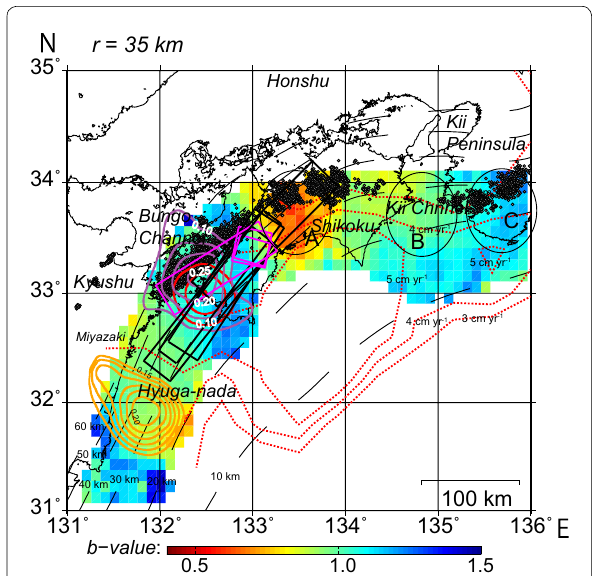
Fig. 4 b -value map of Fig. 3c with SSEs and LFEs superimposed. Large black circles (A, B, and C) denote locations corresponding to p value tests in Fig. 5 (Utsu 1992). Red dotted lines indicate the slip deficit rates (SDRs) by Yokota et al. (2016). Other symbols and meanings are identical to those for Fig.